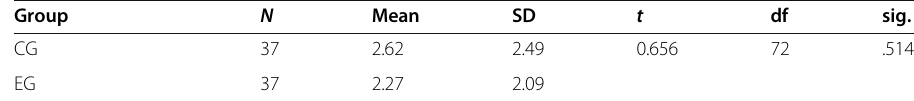
Table 1 Introduction to algorithms course scores